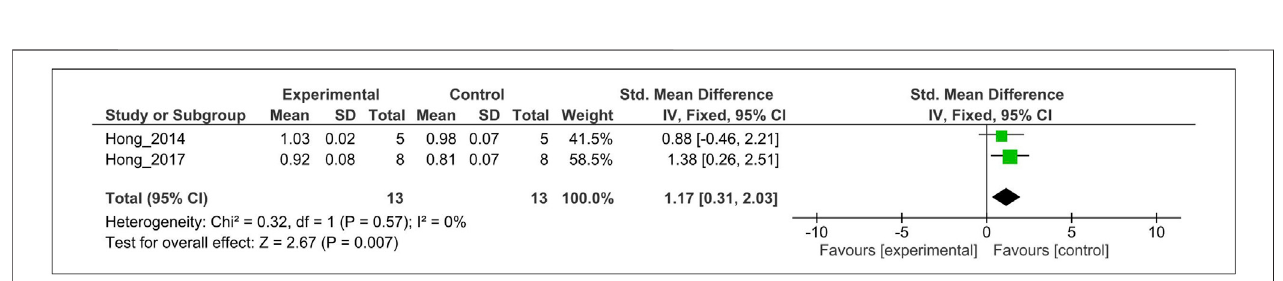
FIGURE3| ForestplotshowingtheeffectsofMTonIL-1 β ,TNF- α ,andMMP-13levels. (A) IL-1 β (B) TNF- α ,and (C) MMP-13levels.TheunitforTNF- α ispg/ml.MT, melatonin; IL-1 β , interleukin-1 β ; TNF- α , tumor necrosis factor- α ; MMP-13, matrix metalloproteinase-13; CI, con fi dence interval.